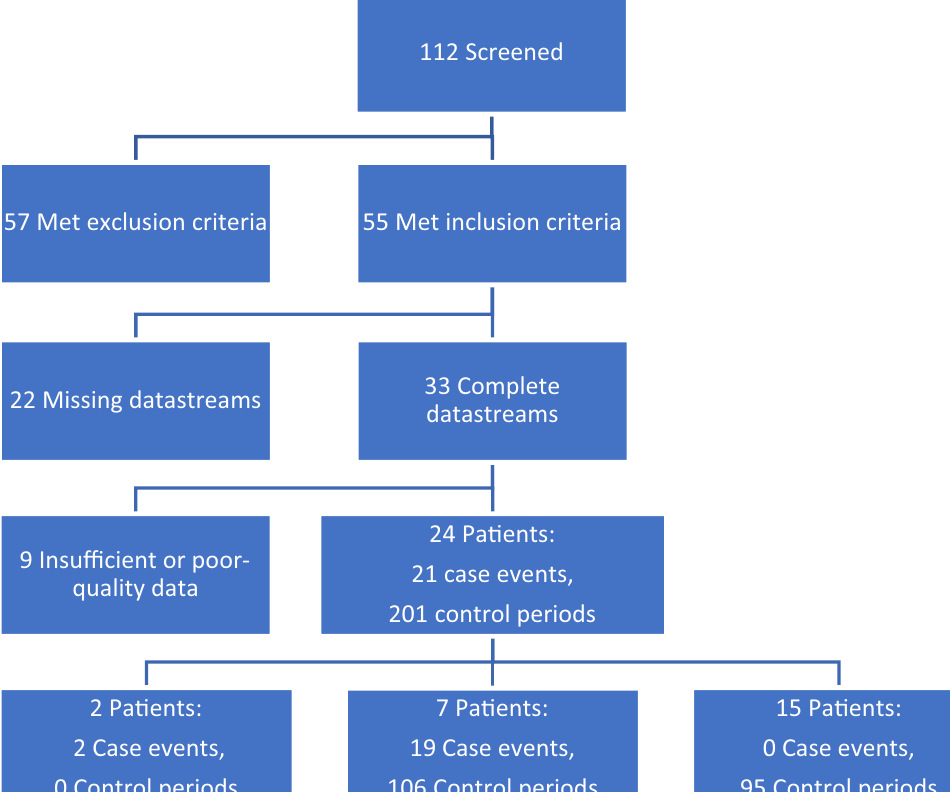
Figure 2. Consort diagram demonstrating the final data set. An elevated ICP event (≥ 20 cm H 2 O for 10 min) comprised a case event; events were considered independent if they occurred at least 5 h apart in the same patient. Control periods consisted of 6-h durations in which ICPs remained < 20 cm H 2 O. Thus, each patient could provide case events and control periods. Data was regarded as “insufficient” if > 20 min (~ 10% of a record) was of poor quality or